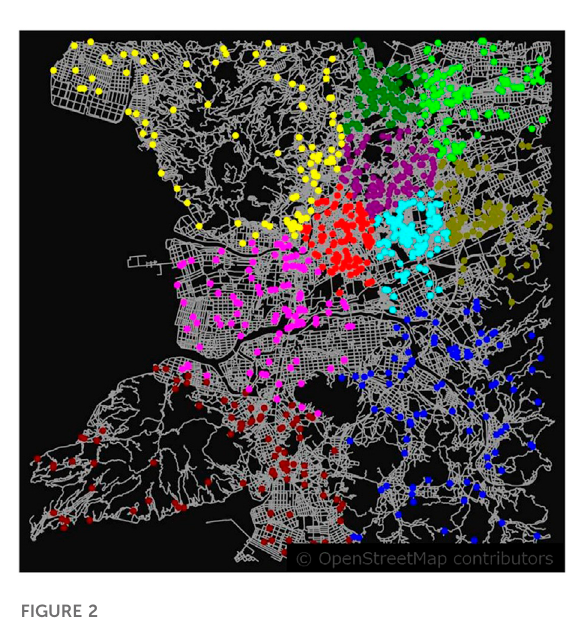
FIGURE 2 Ten instances with different geographic distributions in the base